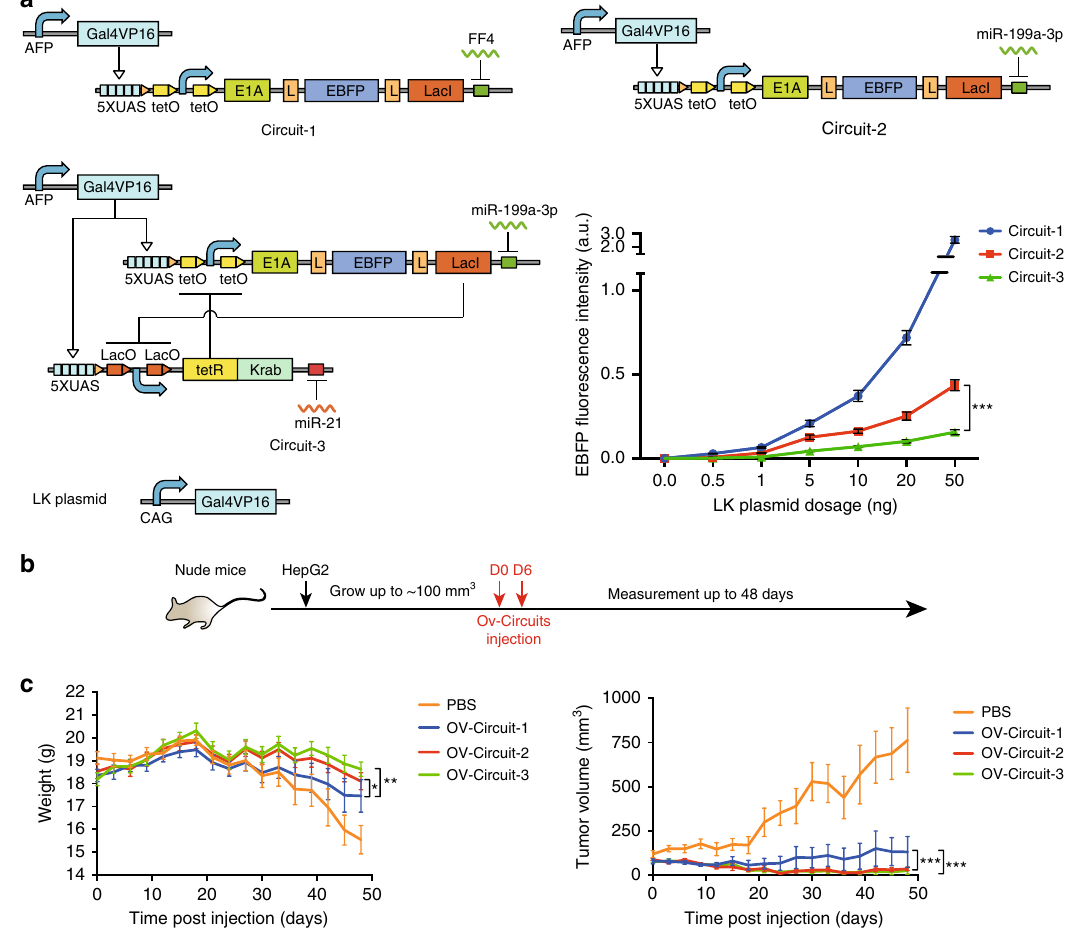
Fig. 3 Comparison of the sensory switch circuit with the other switch circuits in vitro and in vivo. a Circuits performance in response to leaky expression of Gal4VP16 in vitro. Circuits were co-transfected along with varying amount of the CAG-driven Gal4VP16 (LK plasmid) as leaky expression into HEK293 cells. Each data point shows mean ± s.d. from three independent replicates, * P < 0.05, ** P < 0.01, *** P < 0.001. b Schematic diagram of in vivo experimental design with xenografted HepG2 nude mouse model. c 1 × 10 9 VP of OV-Circuits were injected into xenografted tumor twice a week right after the size of tumor reached ~100 mm 3 . PBS was used as a negative control. The left panel shows the mouse weight after treatment. Each data point shows the mean ± s.d. weight (n = 10) at indicated day. The right panel shows the xenografted tumor size after treated. Each data point shows the mean ± s.d. tumor size ( n = 10) at indicated day, * P < 0.05, ** P < 0.01, *** P < 0.001, Student ’ s t -test was performed. Source data are provided as a Source Data fi